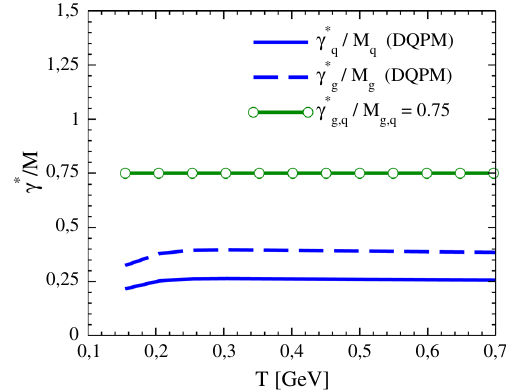
Fig. 1 Ratio between widths calculated in DQPM approach and the Pole Mass M i as function of temperature for quarks (blue solid line) and gluons (blue dashed line). The green solid line is the corresponding case with constant ratio fixed to γ ∗